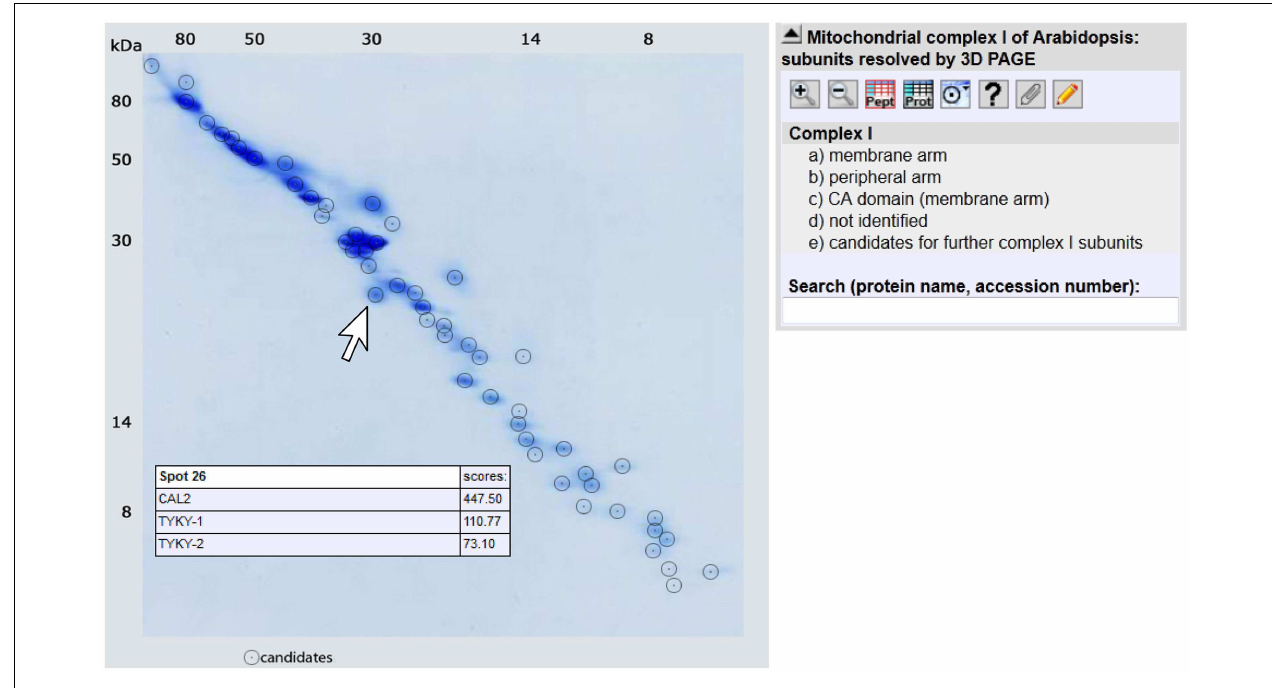
subunit. Upon clicking into the spot the protein names are converted into stable links which can be used to obtain further information. Protein information also can be obtained by clicking into the menu given to the right or by entering protein names or accessions into the search field below the menu.